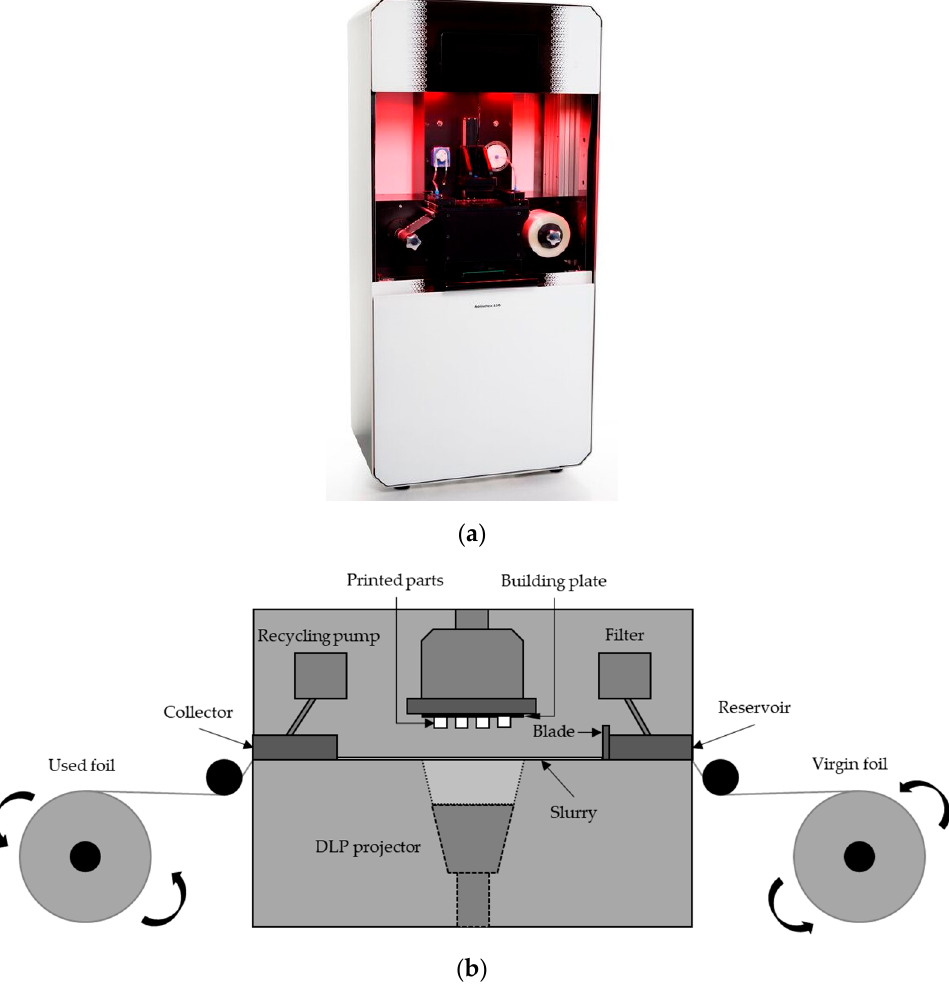
Figure 1. ( a ) Admaflex 130; ( b ) schematic of the Admaflex 130 DLP process. A single-layer curing approach was utilised to assess the critical exposure energy and depth of penetration by measuring the cure depth at various exposure energies.